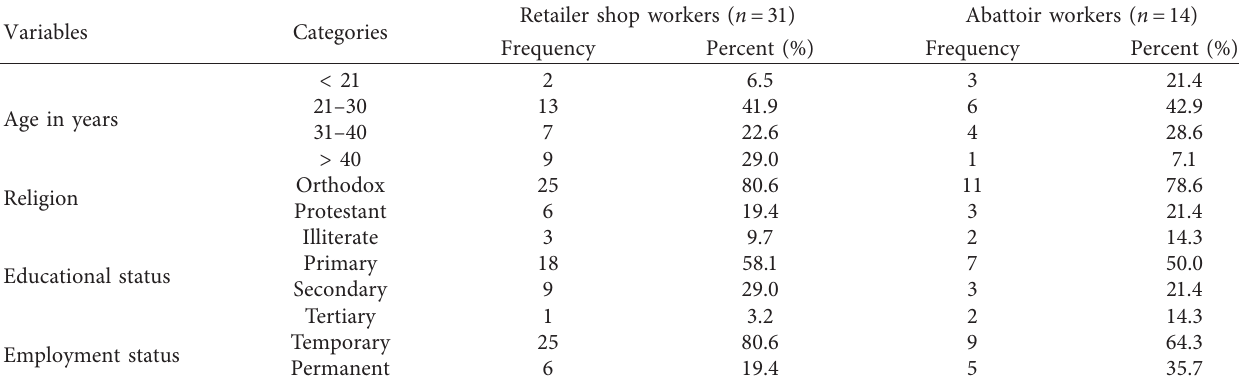
Table 2: Sociodemographic characteristics of retailer shops and abattoir workers in Ambo, West Shewa, Ethiopia (January 2016 to May 2017).